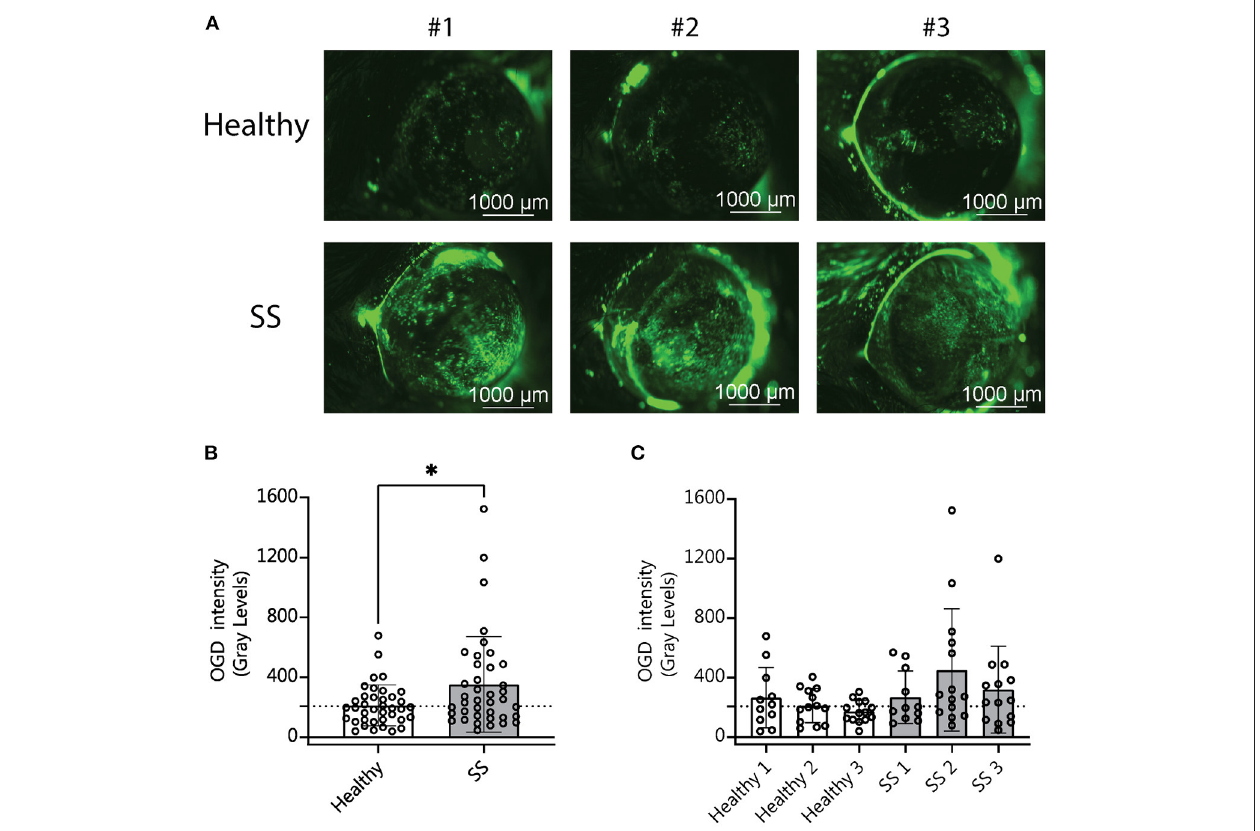
FIGURE 4 | Mice colonized with SS fecal material had increased corneal barrier disruption after desiccating stress compared with mice colonized with fecal material from healthy patients. (A) Representative images of corneal permeability for animals humanized with either healthy or SS patient stool. Corneal barrier integrity was assessed by measuring the epithelial permeability to Oregon-green-dextran dye (OGD). (B,C) Cumulative OGD intensity measurement data from humanized mice subjected to 5 days of DS. Each data point represents the intensity value for one animal (averaged over the two eyes). (B) Shows the combined data for animals humanized with healthy vs. SS patient stools ( n = 3 donors per group). (C) Shows the same data separated by patient donor. Statistical significance was assessed using non-parametric Mann-Whitney U-tests. * P ≤ 0.05.